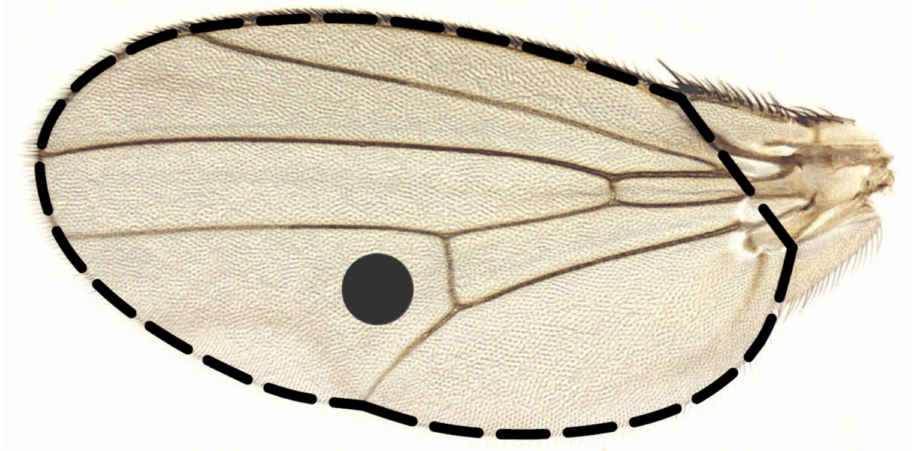
Figure 1. The wing of D. melanogaster , showing the region (grey circle) used for counting the trichomes and estimating the size of epidermal cells and the limits (dashed line) of the measurement of wing